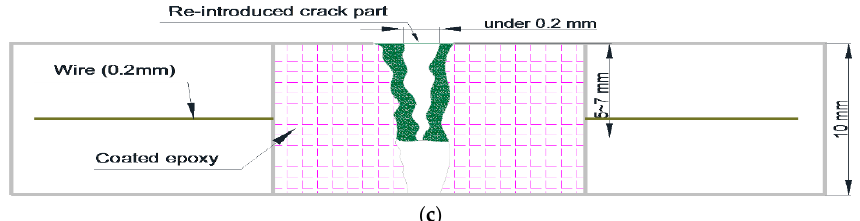
Figure 5. Conceptual diagrams: ( a ) depth of the stick ingredients inside crack; ( b ) re-introducing crack by three point bending machine; ( c ) crack formation after re-introducing crack.